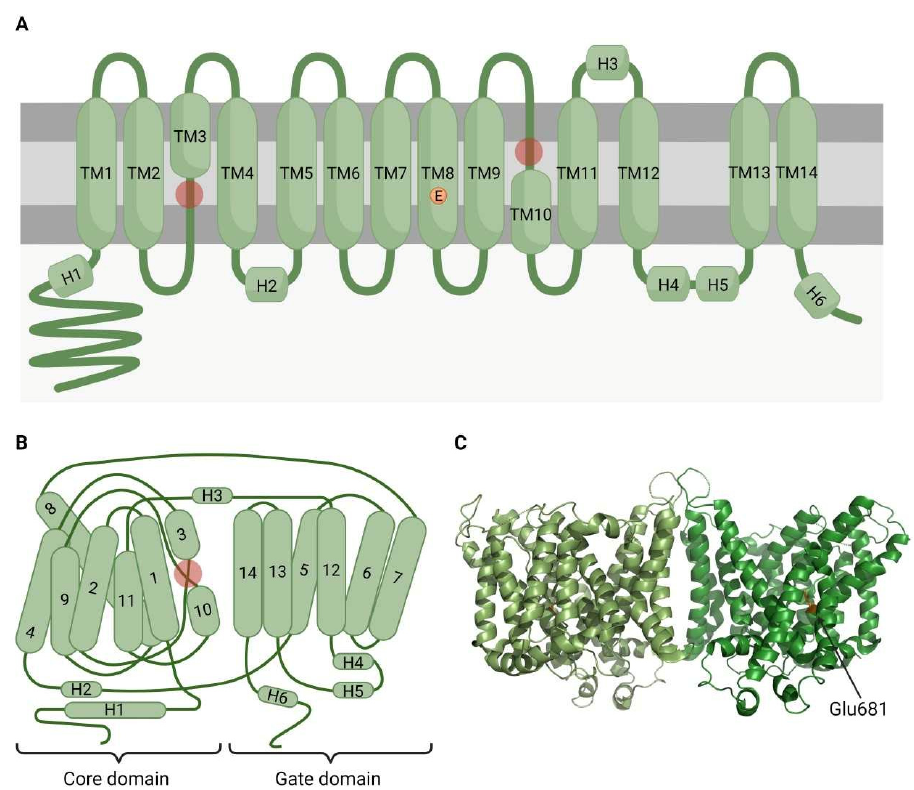
Figure 1. Structural characteristics of SLC4 channels. Bicarbonate transporters from the SLC4 family have slightly different functions, but the structure is generally conserved between them. The structure presented in this figure corresponds to SLC4A1 channel (PDB reference 4YZF). ( A ) SLC4 channels present 14 transmembrane α‐ helices (TM1 ‐ 14) connected through loops that occasionally present amphipathic helices (H1 ‐ 6). TM3 and TM10 are two half ‐ helices, and their N ‐ termini regions form the active site (red circles). In the TM8 segment, Glu681 (orange, E) is a blocker of the active site. ( B ) The folded protein conforms two different domains: the core domain, which is formed by helices TM1 ‐ 4 and TM8 ‐ 11; and the gate domain, which consists of TM5 ‐ 7 and TM12 ‐ 14. N ‐ termini of TM3 and TM10 face each other to form the active site (red circle). ( C ) SLC4 channels form dimers that interact through a dimerization interface constituted by TM6 and TM7, which are part of the gate